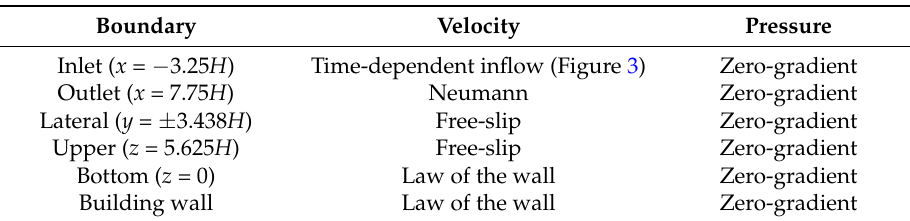
Table 2. Boundary conditions for velocity and pressure.